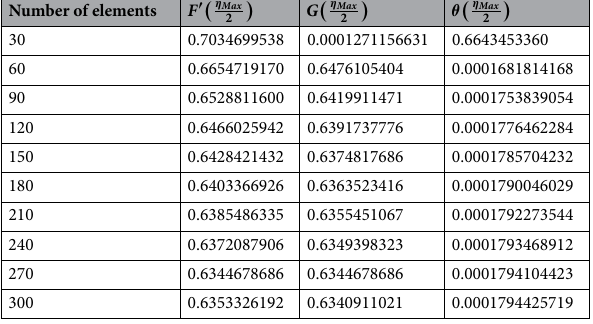
Table 2. Simulations of F